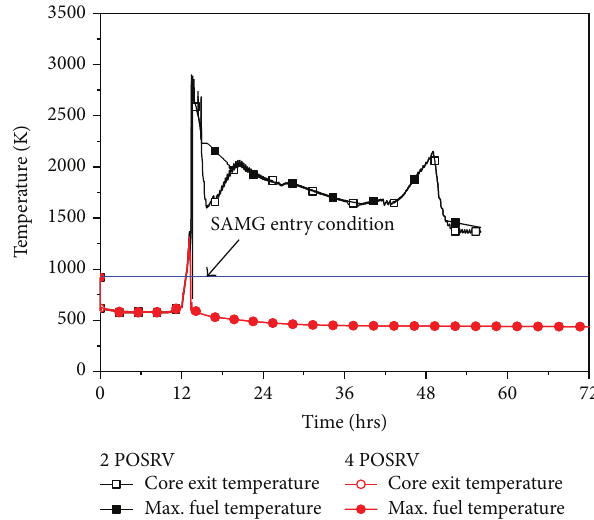
Figure 13: Primary injection core exit and fuel